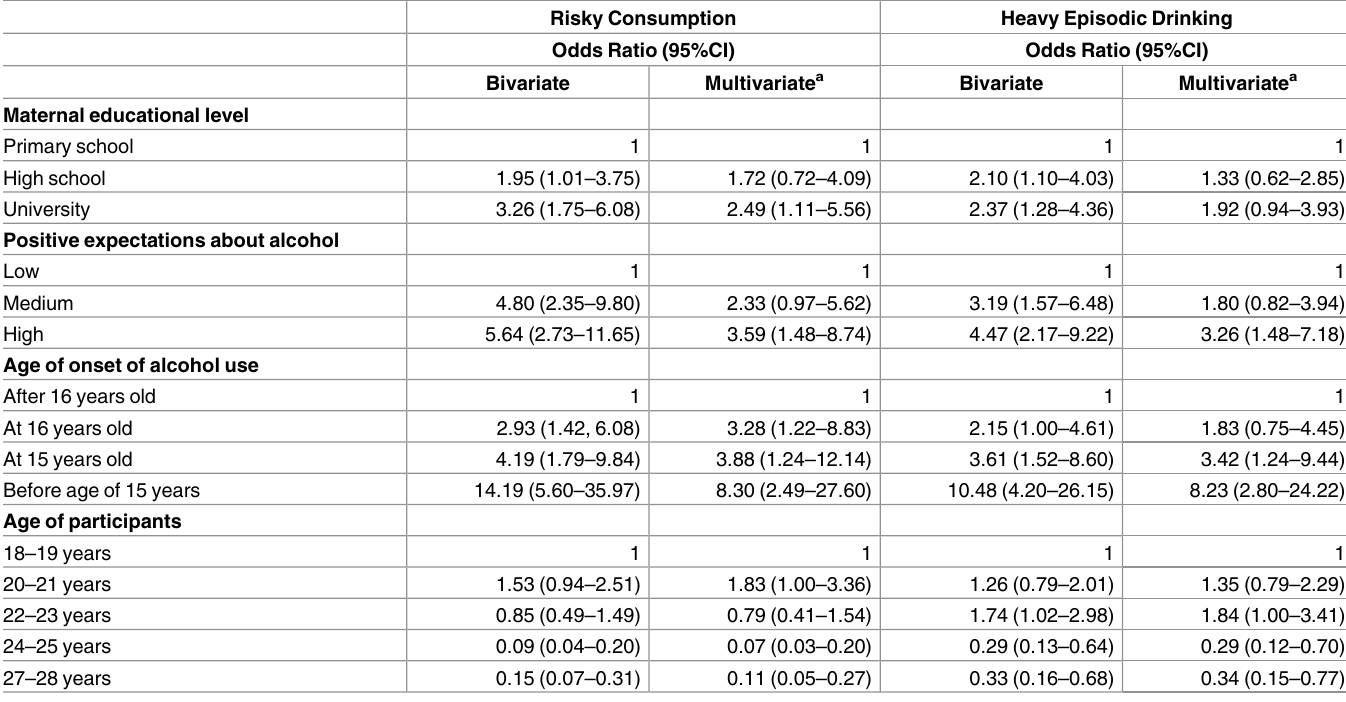
Table 6. Influence of characteristics of male subjects and family background on risky consumption and heavy episodic drinking: Generalized Linear Mixed